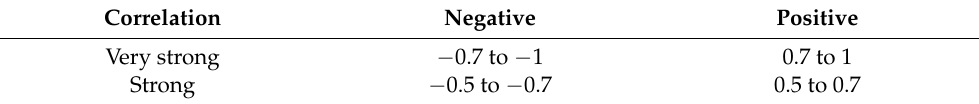
Table 9. Strength of association.